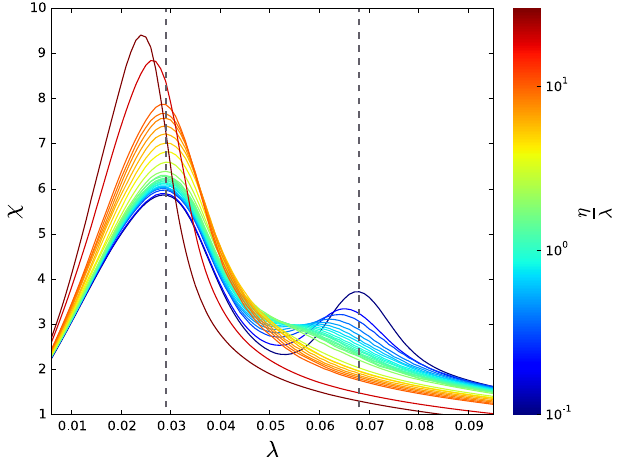
FIG. 6. Susceptibility χ as a function of the spreading rate λ for different ratios of interlayer and intralayer spreading ratings, η = λ , for a fixed value of μ ¼ 1 over a two-layer multiplex system, where each layer has n ¼ 10 3 — the first with γ ≈ 2 . 2 and the second with γ ≈ 2 . 8 . Both have h k i ≈ 8 . The simulated values are ð η = λ Þ ¼ 0 . 1 , 0.2, 0.3, 0.4, 0.5, 0.6, 0.7, 0.8, 0.9, 1.0, 1.1, 1.2, 1.3, 1.4, 1.5, 1.6, 2, 3, 4, 5, 6, 7, 8, 9, 10, 20,